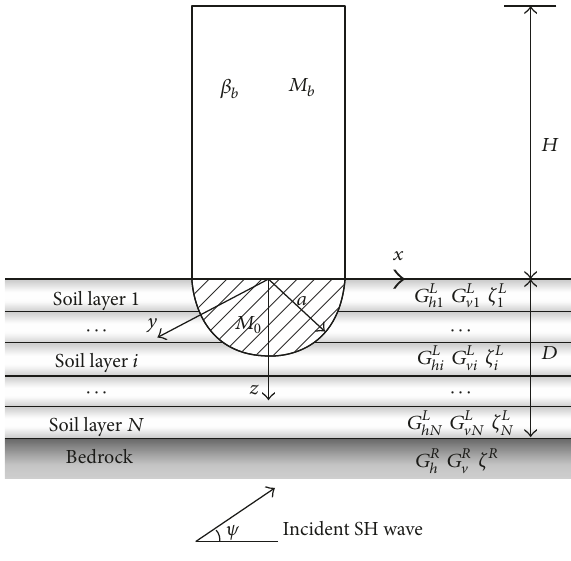
Figure 1: Foundation-shear wall